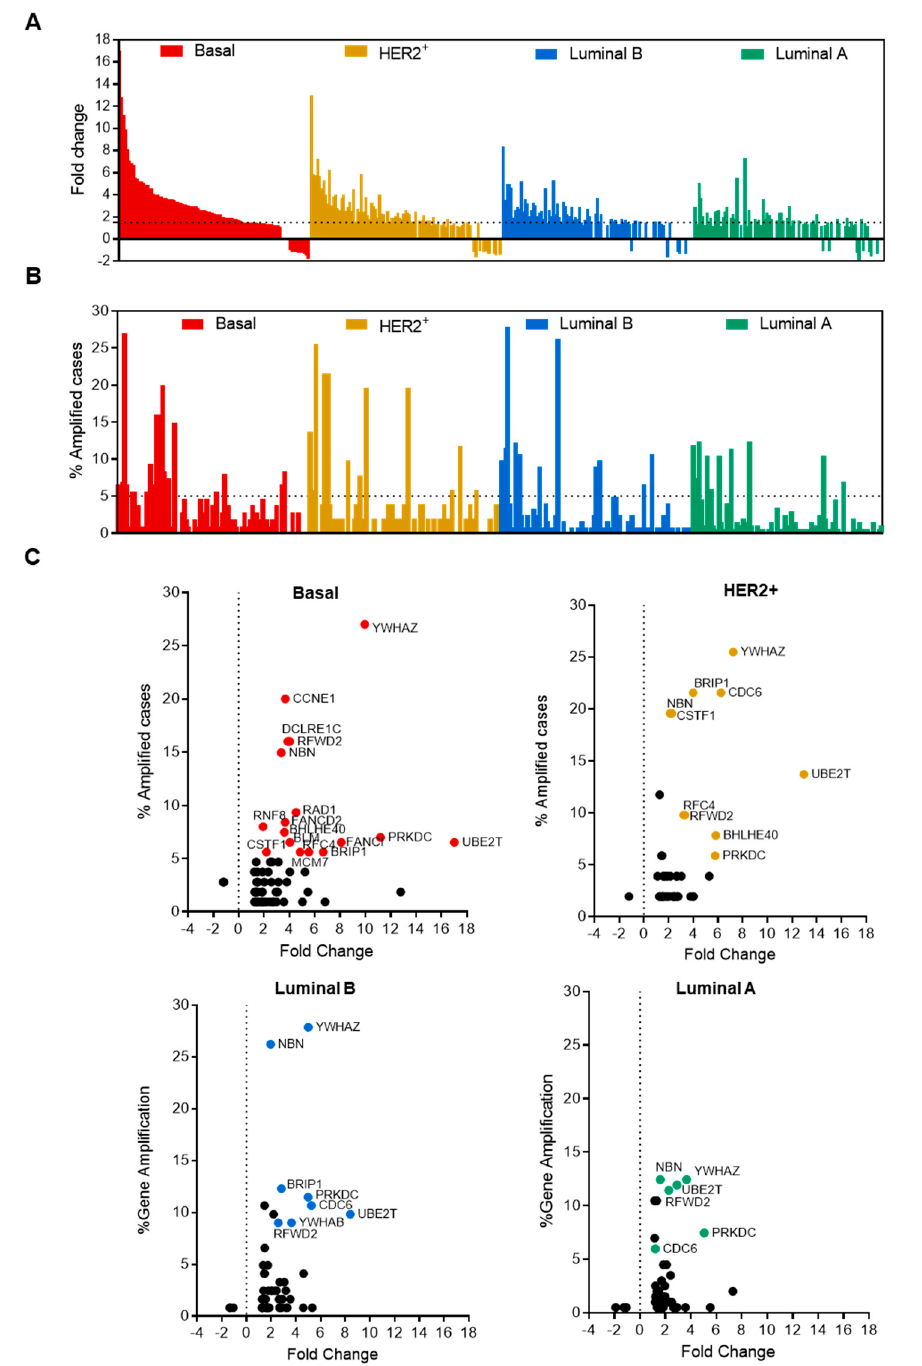
Figure 2. Amplification and expression change of DNA damage response genes in different breast cancer subtypes. ( A ) Bar graph showing fold change expression or ( B ) the percentage of amplified cases of genes involved in the ATR, Fanconi Anemia, ATM , and BARD1 pathways in each breast cancer subtype (red, basal-like; yellow, HER2 + ; blue, luminal B and green, luminal A). The dot line represents the threshold we mark for each alteration. ( C ) Dot plot of DNA damage response genes showing fold change expression in X-axes and percentage of amplified cases in Y-axes for each molecular subtype. Those genes that exceed both thresholds are highlighted following the same color criteria than in A.